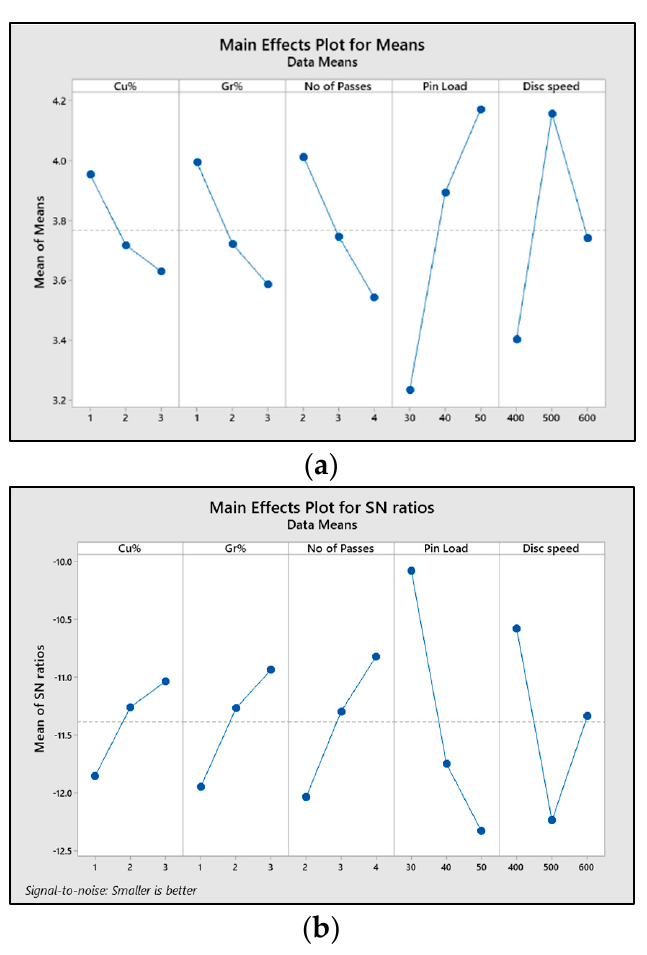
Figure 7. Main effect plot for ( a ) mean values of wear rate and ( b ) SN ratios of wear rate for varying parameters (Cu%, Gr%, No of passes, pin load, disc speed).